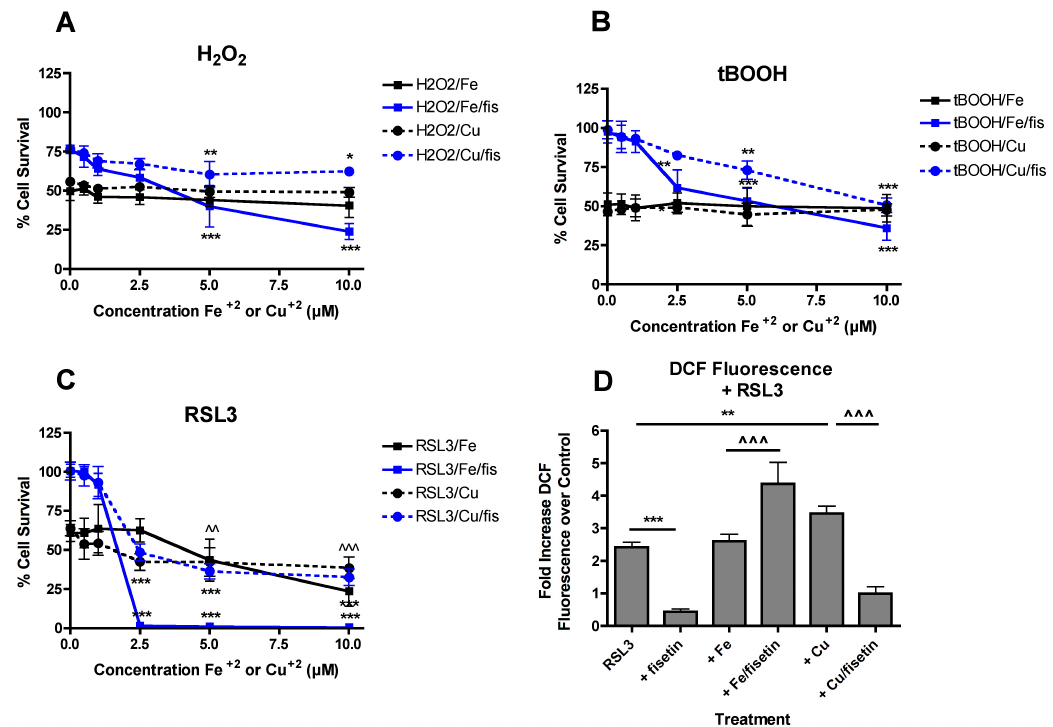
Figure 4. FeCl 2 and CuCl 2 modulate the e ff ects of fisetin on protection from multiple toxicities. FeCl 2 and CuCl 2 reduce fisetin-mediated protection against hydrogen peroxide (H 2 O 2 ) ( A ) or t-butyl peroxide (tBOOH) ( B ) toxicity. HT22 cells were treated with 0.5 mM H 2 O 2 or 2.5 µ M tBOOH in the presence of 10 µ M fisetin and / or FeCl 2 or CuCl 2 at the indicated concentrations. Cell survival was measured after 24 h with the MTT assay. The experiments were done in quadruplicate and the results are the average of 4 independent experiments. ( C ) FeCl 2 and CuCl 2 di ff erentially a ff ect fisetin-mediated protection against RSL3 toxicity. HT22 cells were treated with 100 nM RSL3 in the presence of 5 µ M fisetin and / or FeCl 2 or CuCl 2 at the indicated concentrations. Cell survival was measured after 24 h with the MTT assay. The experiments were done in quadruplicate and the results are the average of 5 independent experiments. ( A – C ), * indicates p < 0.05, ** indicates p < 0.01 and *** indicates p < 0.001 relative to fisetin + toxin alone. ( C ), ˆˆ indicates p < 0.01 and ˆˆˆ indicates p < 0.001 relative to RSL3 alone for both FeCl 2 and CuCl 2 . ( D ) Cells were treated with 250 nM RSL3 alone or in the presence of 10 µ M fisetin and 5 µ M FeCl 2 or CuCl 2 . After 4 h, ROS levels were determined using CM-H 2 DCFDA as described in Materials and Methods. The treatments were done in sextuplicate and the results are the average of 4 independent experiments. ** p < 0.01, *** p < 0.001 relative to RSL3 alone. ˆˆˆ p < 0.001 relative to RSL3 + FeCl 2 or CuCl 2